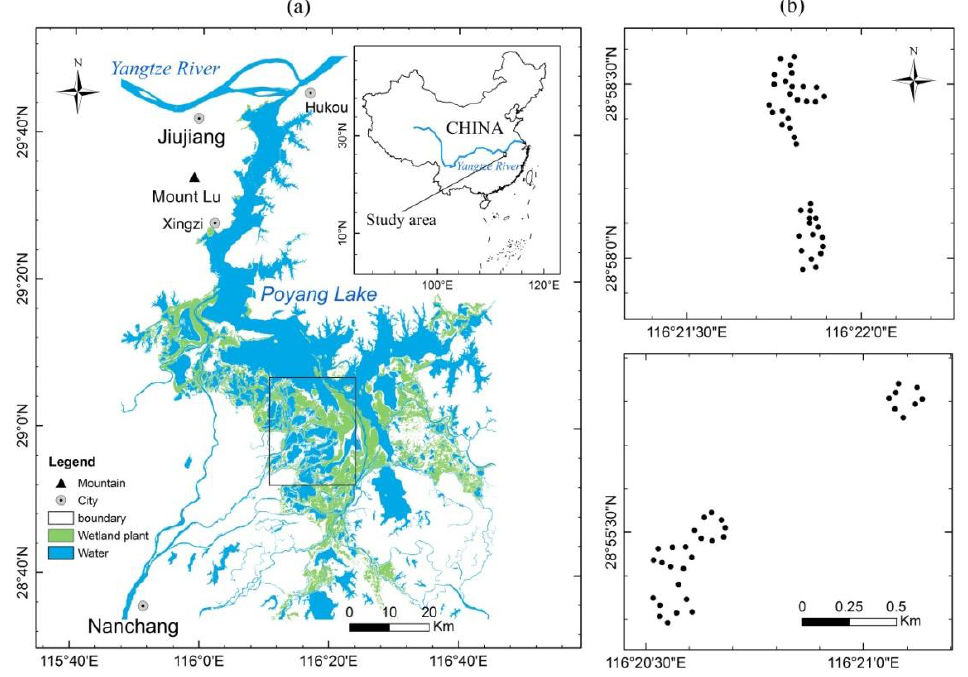
Figure 1. ( a ) Location of the study area in Poyang Lake, China and ( b ) the spatial distribution of 71 Carex